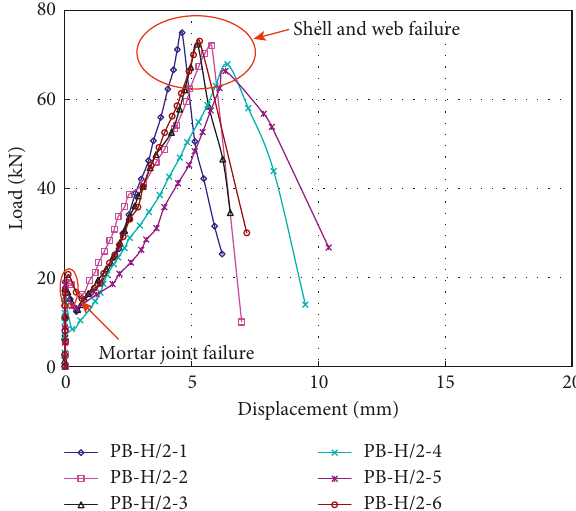
Figure 14: Load-displacement response of group PB-H/2.